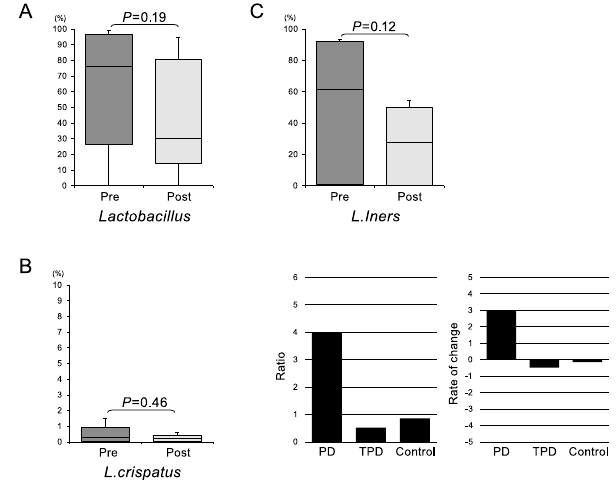
Figure 5 Longitudinal analysis of the abundance of strains of the Lactobacillus genus in the vaginal microbiome in the TPD group. The relative abundance of Lactobacillus was compared between pre- and post- tocolytic treatment for premature labor. A. Lactobacillus genus; B. L. crispatus ; and C. L. iners . We also calculated the post- to pre-treatment ratio for the abundance of L. iners in the PD, TPD, and control